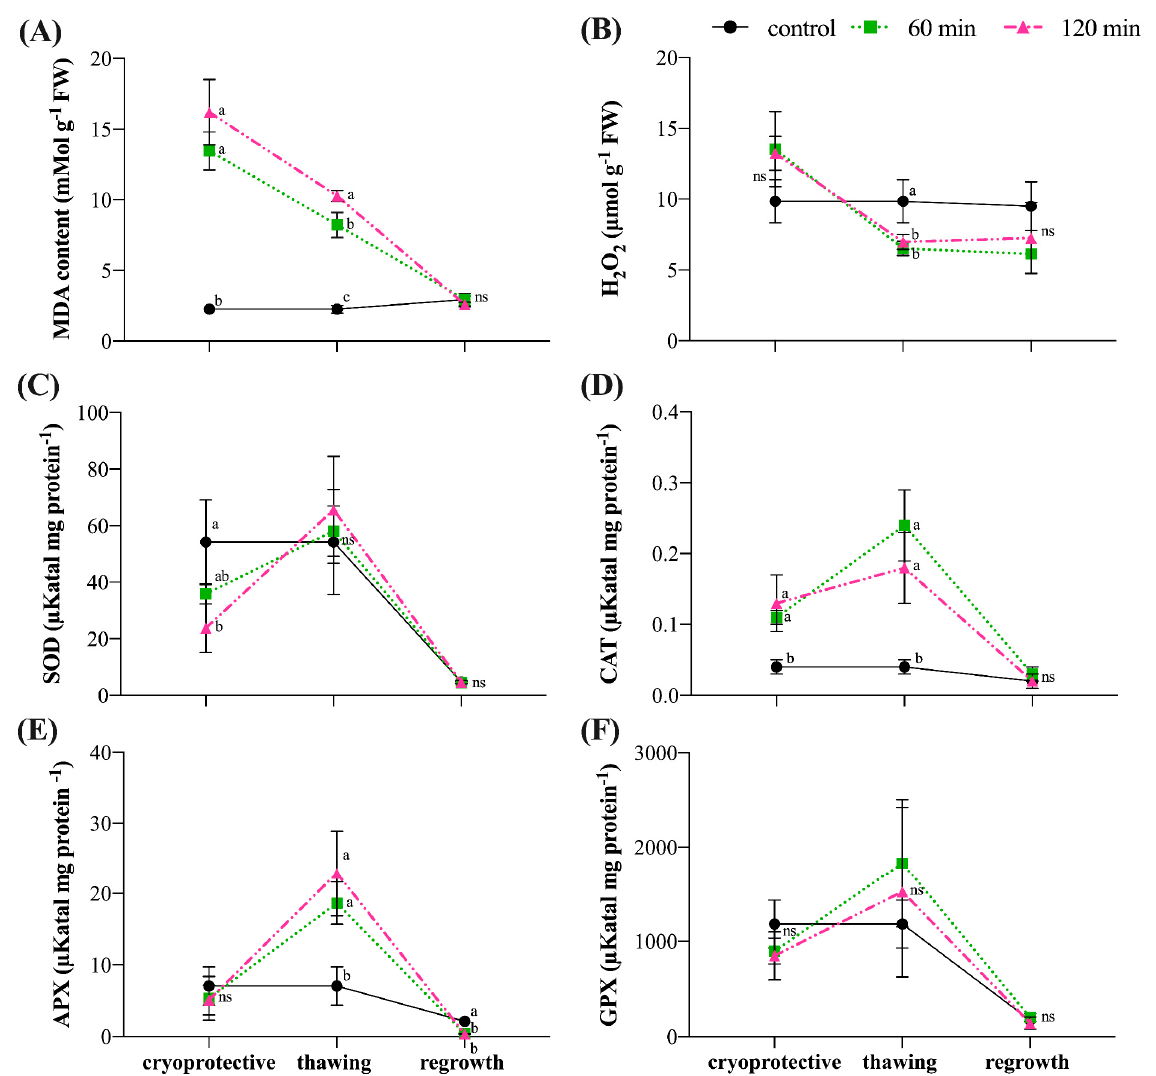
Figure 6. Redox states of G. chacoensis embryogenic cultures, characterizing the steps of the cryopro- tective solution, thawing, and 60 days’ regrowth for the control, 60 min incubation, and 120 min incubation: ( A ) malonaldehyde (MDA) content; ( B ) hydrogen peroxide (H 2 O 2 ) content; ( C ) superoxide dismutase (SOD) activity; ( D ) catalase (CAT) activity; ( E ) ascorbate peroxidase (APX) activity; and ( F ) guaiacol peroxidase (GPX) activity. Bars indicate the standard deviation of the mean. Lowercase letters represent significant differences between incubation times on each step, according to the Tukey test ( p < 0.05). ns: not significant.